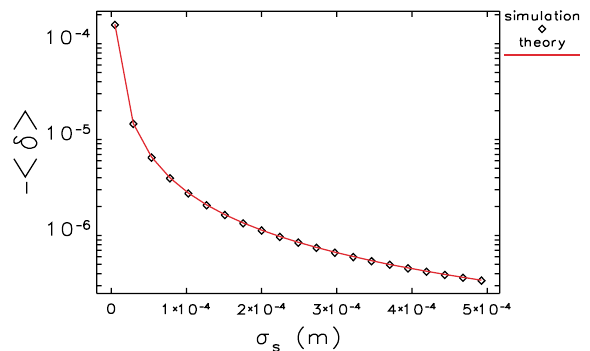
FIG. 4. (Color) Mean fractional momentum offset vs rms bunch length.